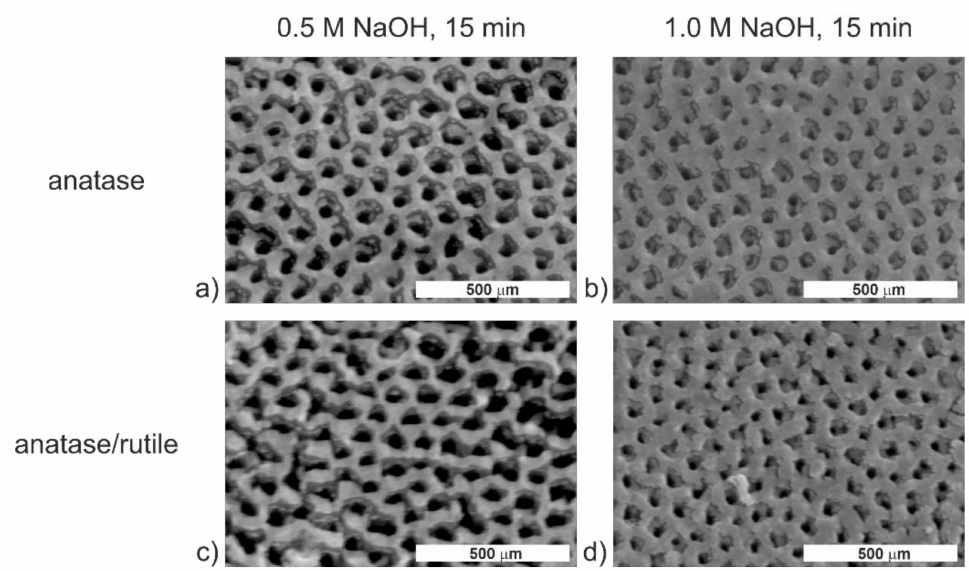
Figure 2. Microphotographs from the FE-SEM of ATO layers modified with 0.5 M ( a , c ) or 1.0 M ( b , d ) NaOH for 15 min. The TiO 2 layers were annealed at 400 ( a , b ) or 600 ◦ C ( c , d ) for 2 h after the modification with